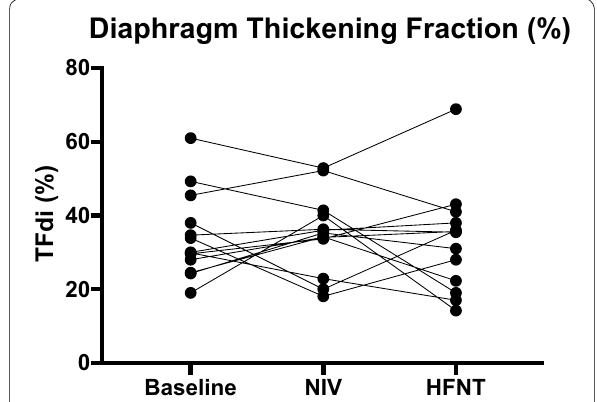
Fig. 2 Individual patient changes in diaphragm thickening fraction. No significant change in diaphragm thickening fraction was observed between baseline conditions or after each device, n